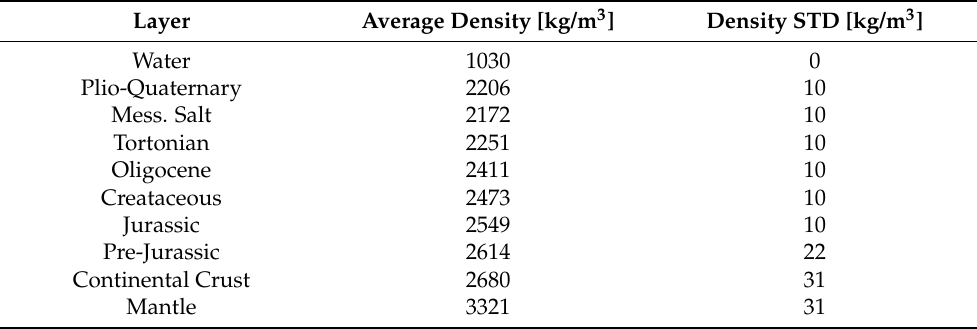
Table 3. Density values and accuracy of the a priori models for Scenario 1 and 2 inversions (Sections 4.2 and